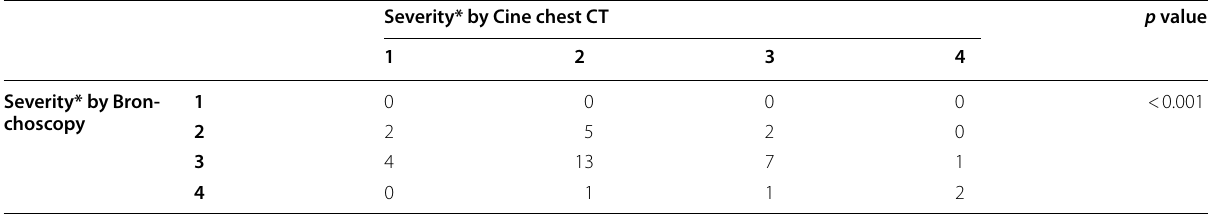
Table 3 Cross-tabulation of results of severity classification of both bronchoscopy and cine chest